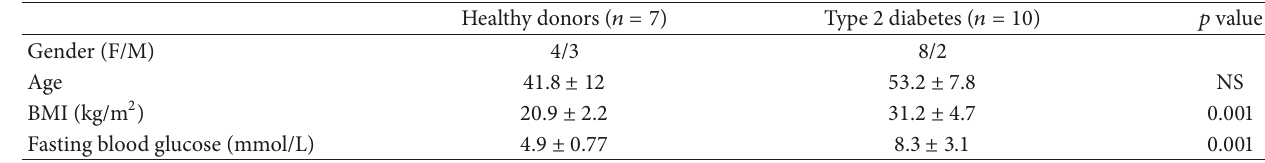
Table 1: Participant